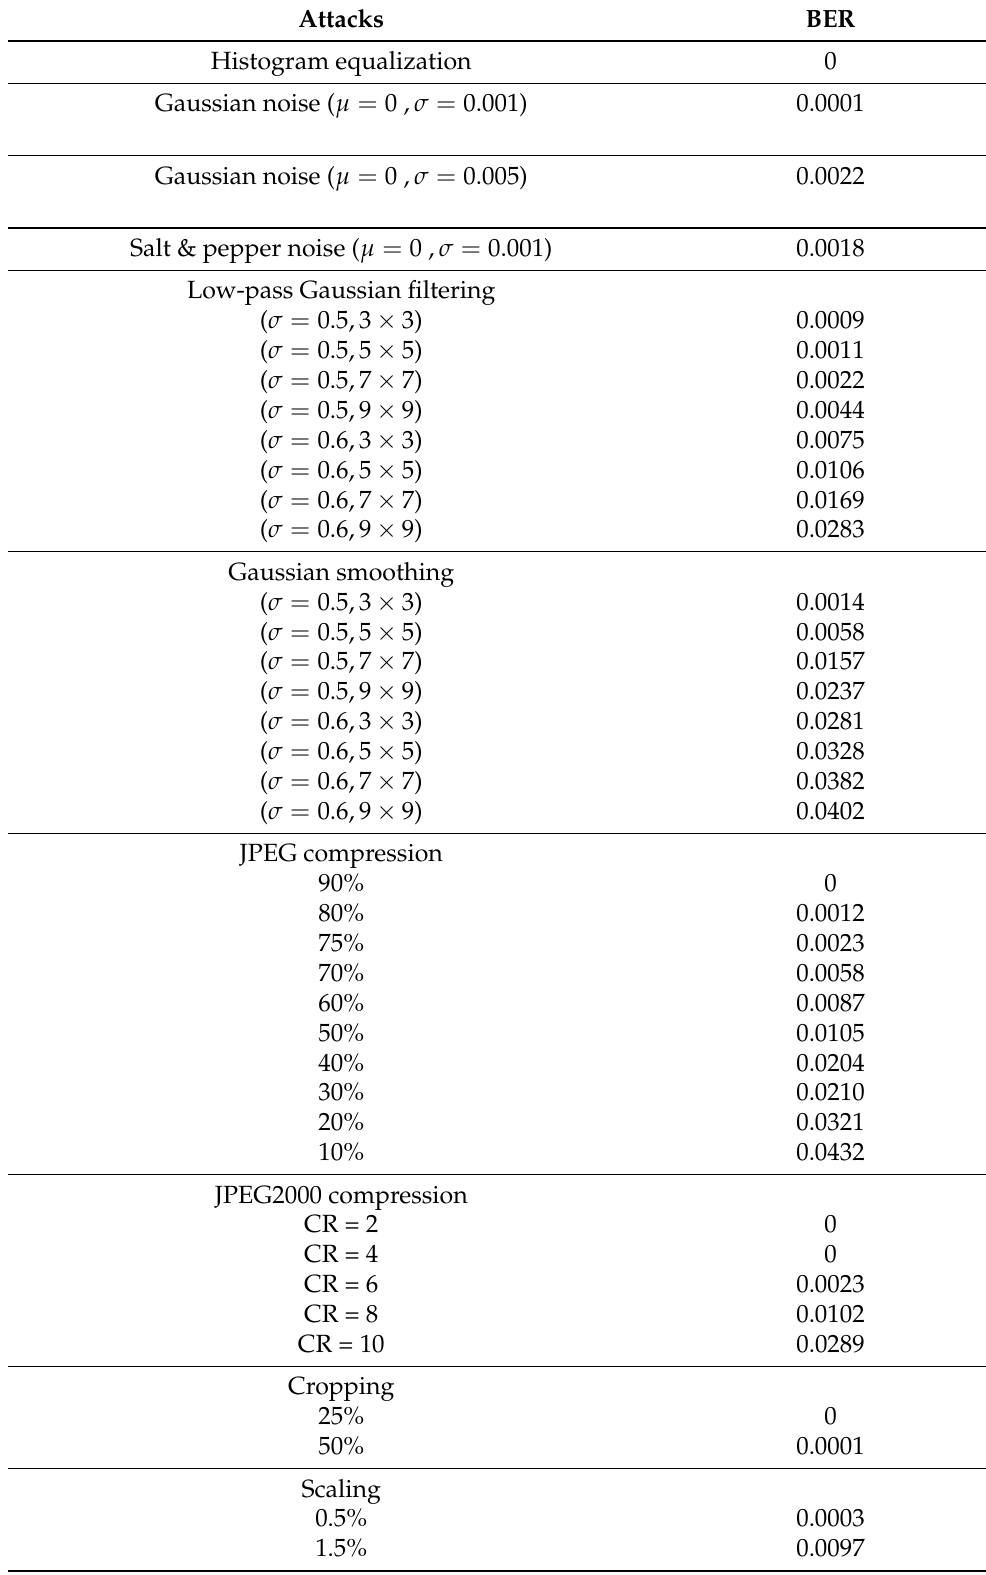
Table A7. Average BER values after several attacks applied to thirty test